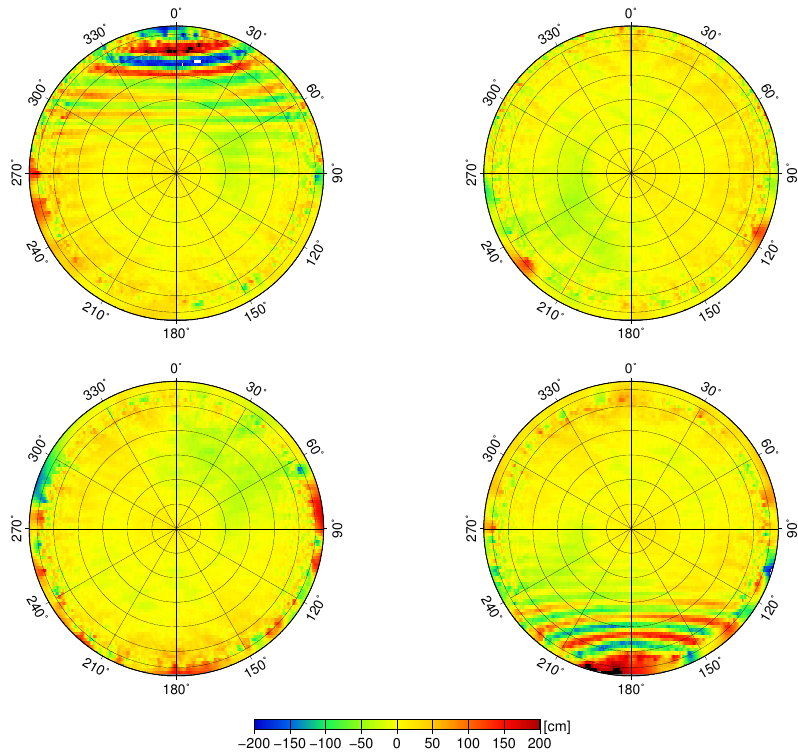
Figure 1. Code residual variation maps of GRACE-A ( top ) and GRACE-B ( bottom ) for June 2014 ( left ) and August 2014 ( right ). Radio occultation measurements on GRACE-A were activated in June